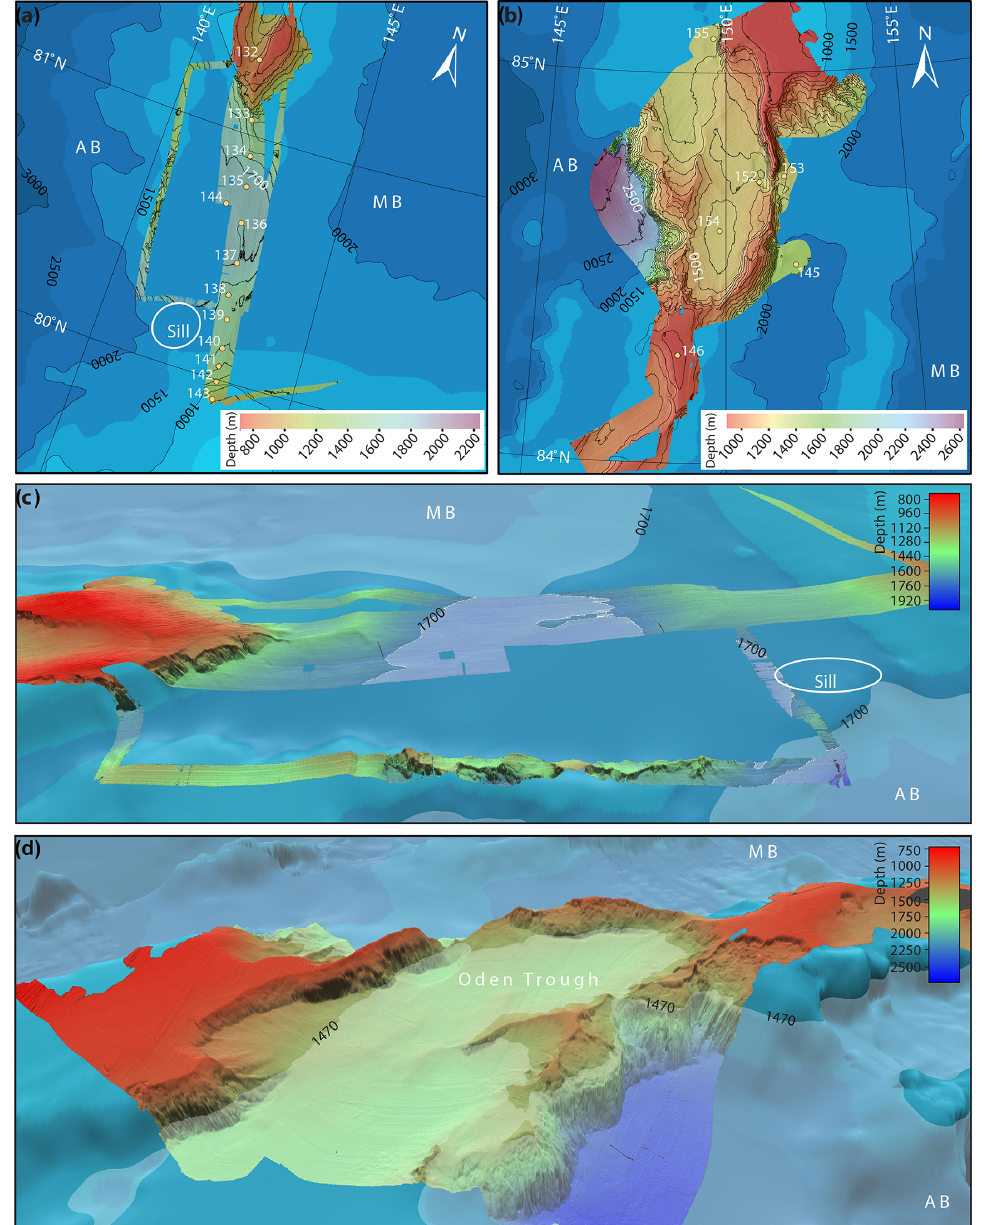
Figure 2. Detailed maps of the southern passage (a, c) and northern passage (b, d) . The likely position of the sill for the southern passage is within the white circle. A semitransparent plane visualize the approximate sill level of 1700m for the southern passage (c) and the actual sill level of 1470m for the northern passage (d)